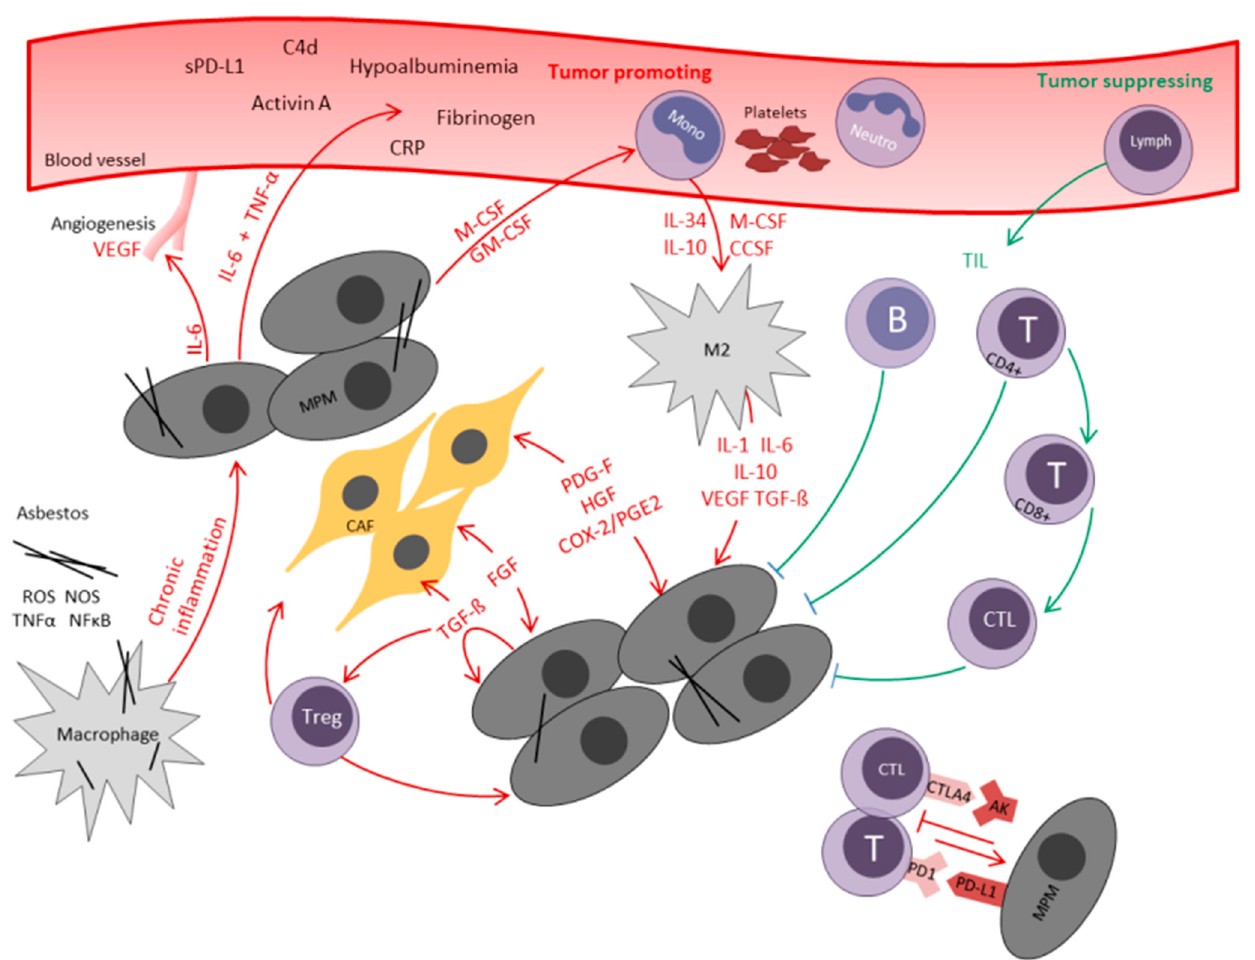
Figure 1. Interaction of local and systemic immune response in malignant pleural mesothelioma. AB antibody , B B-lymphocyte, C4d circulating complement component 4d, CAF cancer associated fibroblast, CCSF C-C motif chemokine ligand 2, COX-2 cyclooxygenase-2, CRP C-reactive protein, CTL cytotoxic T-lymphocyte , CTLA4 cytotoxic T-Lymphocyte Antigen 4, FGF fibroblast growth factor, GM-CSF granulocyte macrophage colony stimulating factor, HGF hepatocyte growth factor, IL interleukin, Lymph lymphocyte, M2 M2-macrophage, M-CSF macrophage colony stimulating factor, Mono monocyte, MPM malignant pleural mesothelioma, NF κ B nuclear factor kappa-light-chain-enhancer B, Neutro neutrocyte, PD-1 programmed cell death protein 1, PD-L1 programmed cell death ligand 1, PDGF platelet derived growth factor, PGE2 prostaglandin E2, RNS reactive nitrogen species, ROS reactive oxygen species, sPD-L1 soluble programmed cell death ligand 1, T T-lymphocyte, TGF-ß transforming growth factor-ß, TIL tumor-infiltrating lymphocyte, TNF- α tumor necrosis factor α , Treg regulatory T-cell, VEGF vascular endothelial growth factor.